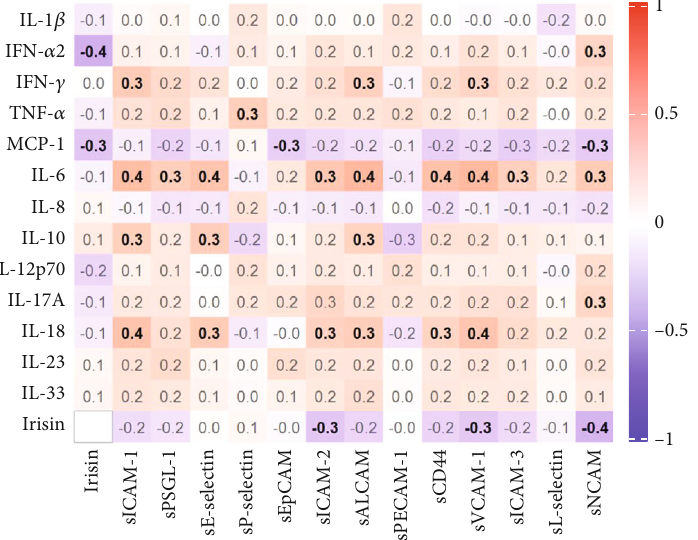
Figure 3: Correlation heat map for irisin and adhesion molecules with cytokine pro fi le in children and adolescents with type 2 diabetes mellitus, metabolic syndrome, and healthy controls. Colored squares of the heat map represent Spearman ’ s rho correlation coe ffi cients; the coe ffi cients ’ font appears black and bold when correlations are statistically signi fi cant and grey when they are not. Squares fi lled in shades of blue represent negative correlations, while those fi lled in shades of red represent positive correlations. Statistical signi fi cance was established as p value ≤ 0.05. IL: interleukin; IFN: interferon; TNF: tumor necrosis factor; MCP: monocyte chemoattractant protein; sICAM: soluble intercellular adhesion molecule; sPSGL: soluble P-selectin glycoprotein ligand; sEpCAM: soluble epithelial cell adhesion molecule; sALCAM: soluble activated leukocyte cell adhesion molecule; sPECAM: soluble platelet endothelial cell adhesion molecule; sVCAM: soluble vascular cell adhesion molecule; sNCAM: soluble neural cell adhesion